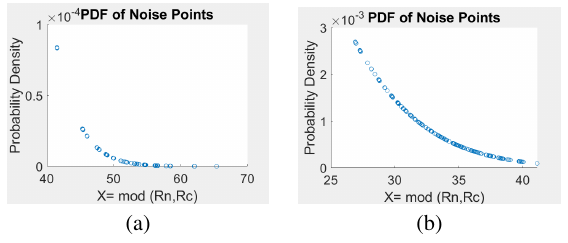
Figure 13: Normal distribution of noise points for voxels